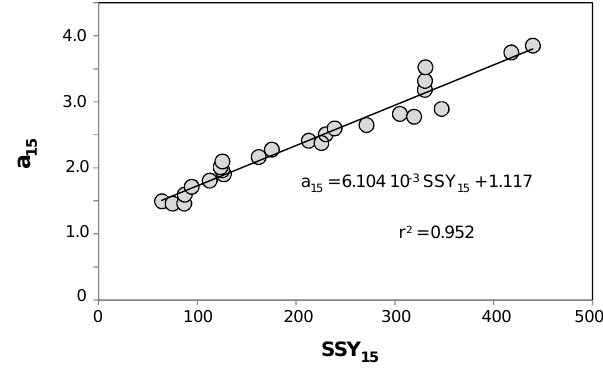
Figure 16. Relationship between the rating curves parameters aver- aged over 15 years. Figure 17. Relationship between the rating curve parameter a av- eraged over 15 years and the averaged values of specific sediment yield over 15